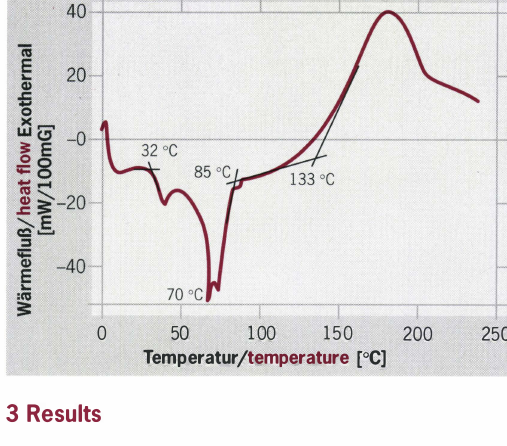
Fig. 2: Viscosity as a function of temperature for a hardener, with an Arrhenius fit through the data